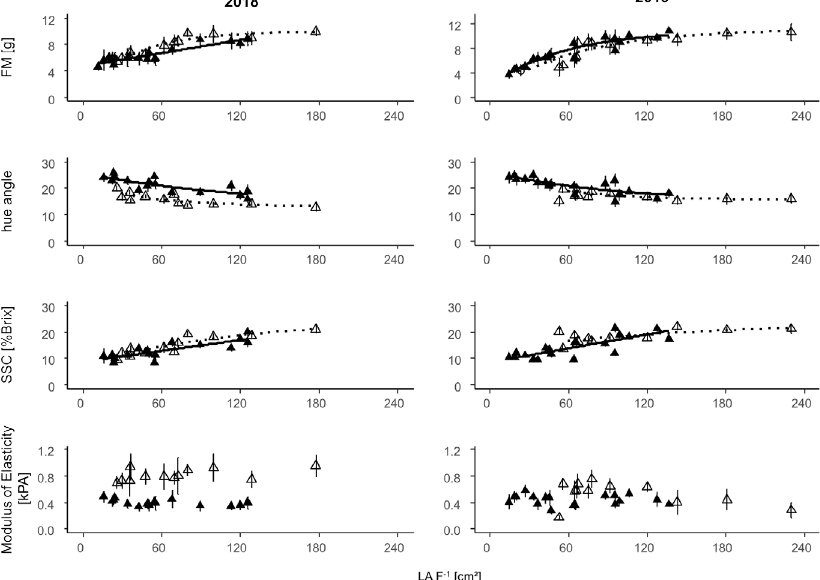
Fig. 8: Means of fresh mass (FM), hue angle (), SSC () and modulus of elasticity (E;) of sweet cherries of 'Bellise' (closed symbol, solid line) and of 'Regina' (open symbol, dotted line) grown with different leaf area to fruit ratio (LA:F) in 2018 and 2019. Error bars show the standard